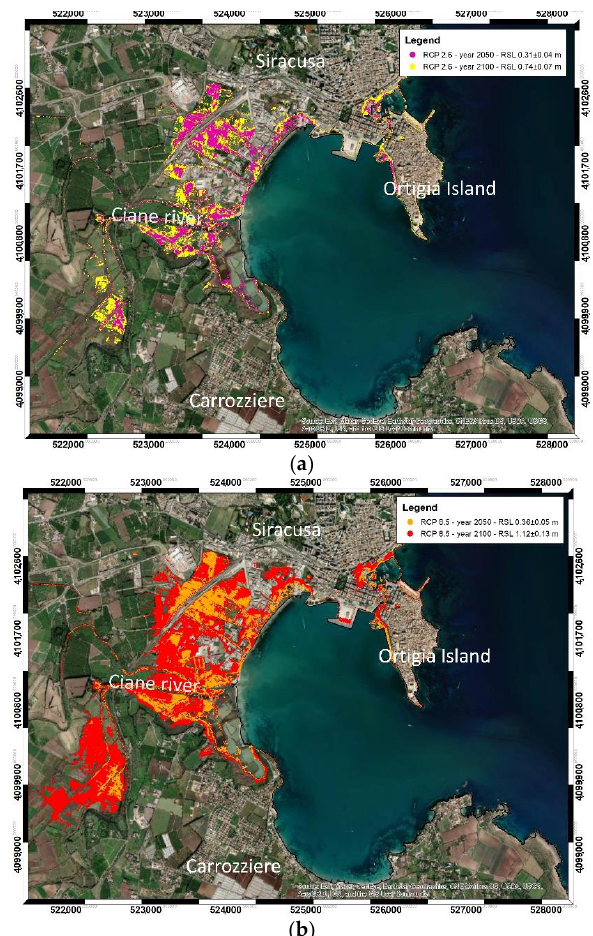
Figure 12. The bay of Siracusa. In colors are reported the expected extension of land flooding in 2050 and 2100 for ( a ) RCP 2.6 and ( b ) RCP 8.5 climatic scenarios for a mean land subsidence at 7 ± 2.5 mm/yr. The expected maximum loss of land is 2.378 km 2 (high-resolution maps are inserted in